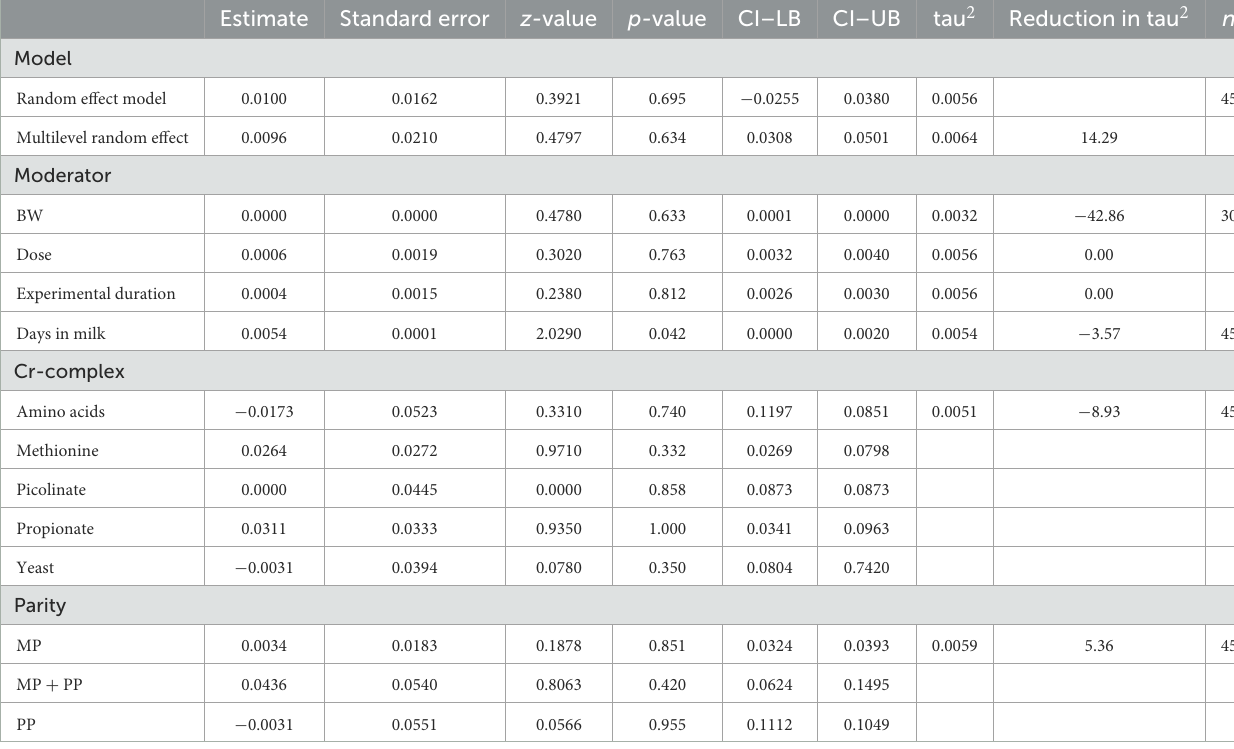
TABLE 5 A summary of statistical models and moderators for milk lactose meta-analysis.